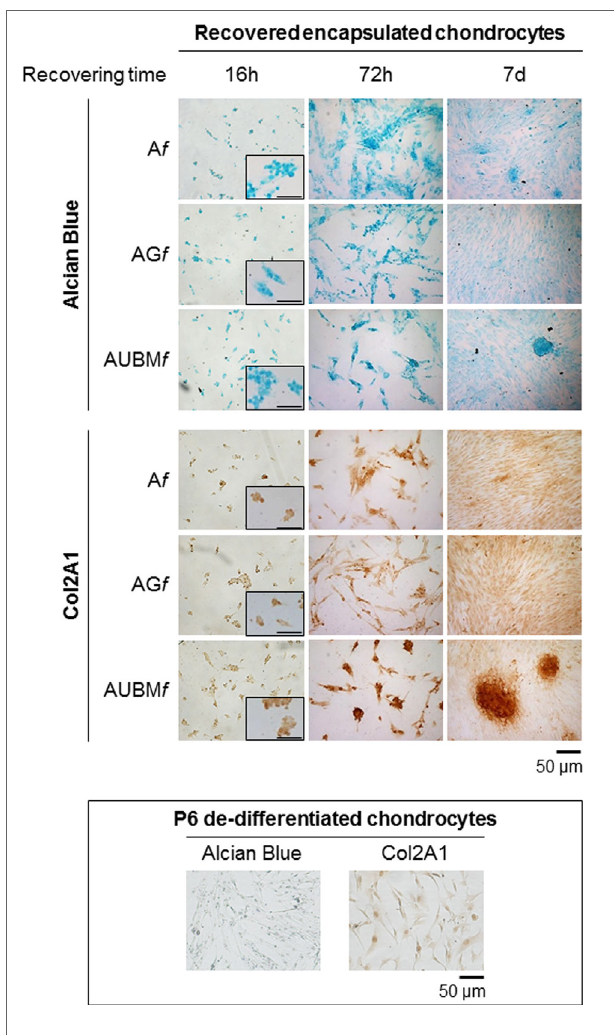
FigUre 7 | Behavior of the embedded cells after they are recovered from the microfibers. Redifferentiated chondrocytes were recovered from microfibers after 14 days of culture, reseeded, grown up to 7 days as monolayered culture in standard medium without adding chondrogenic inducers, and compared with P6 dedifferentiated chondrocytes. The cells were stained by Alcian blue for sulfated GAGs and immunostained for Col2A1 after growing in monolayer for 16 h, 72 h, or 7 days. Optical photomicrographs indicate the maintenance of acquired chondrogenic properties. Bar corresponds to 50 and 100 µm for the